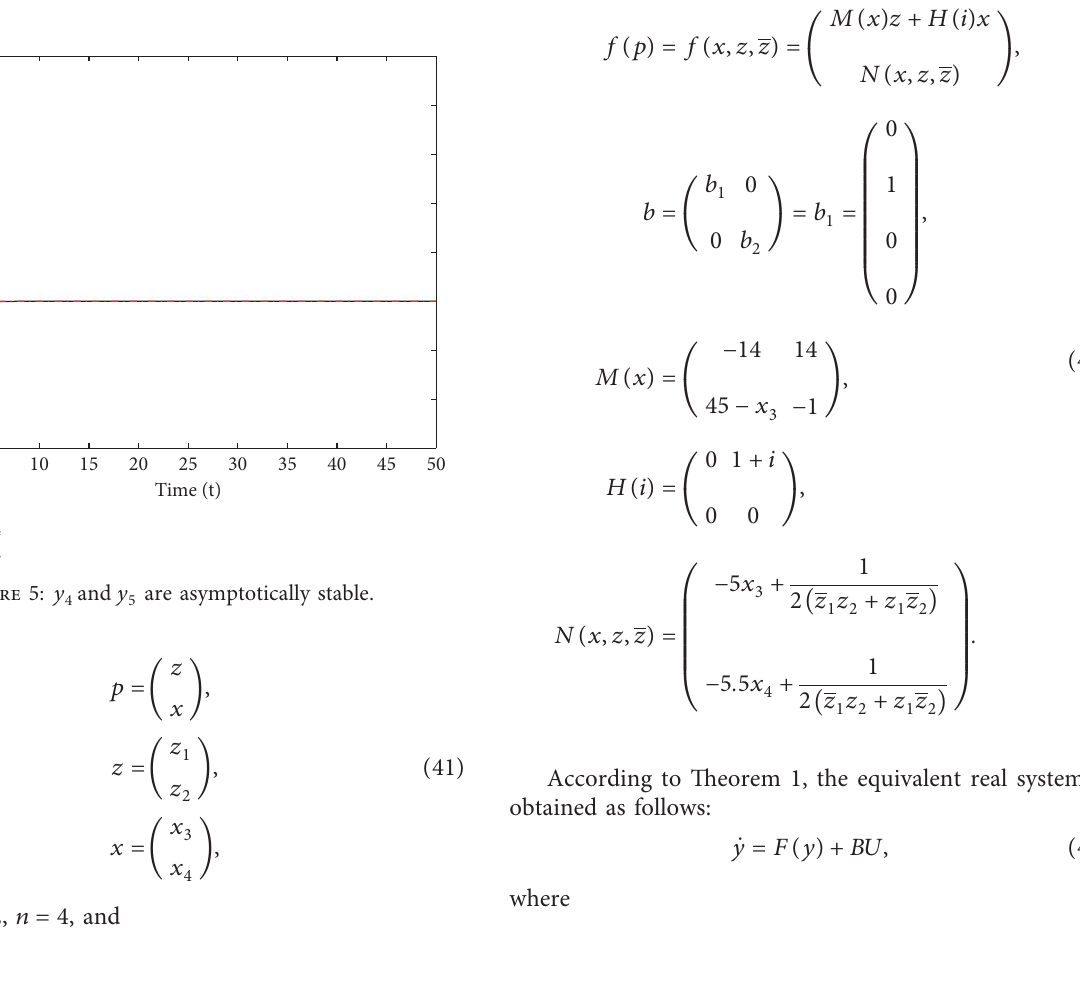
,y , and y are asymptotically stable. 1 2 3